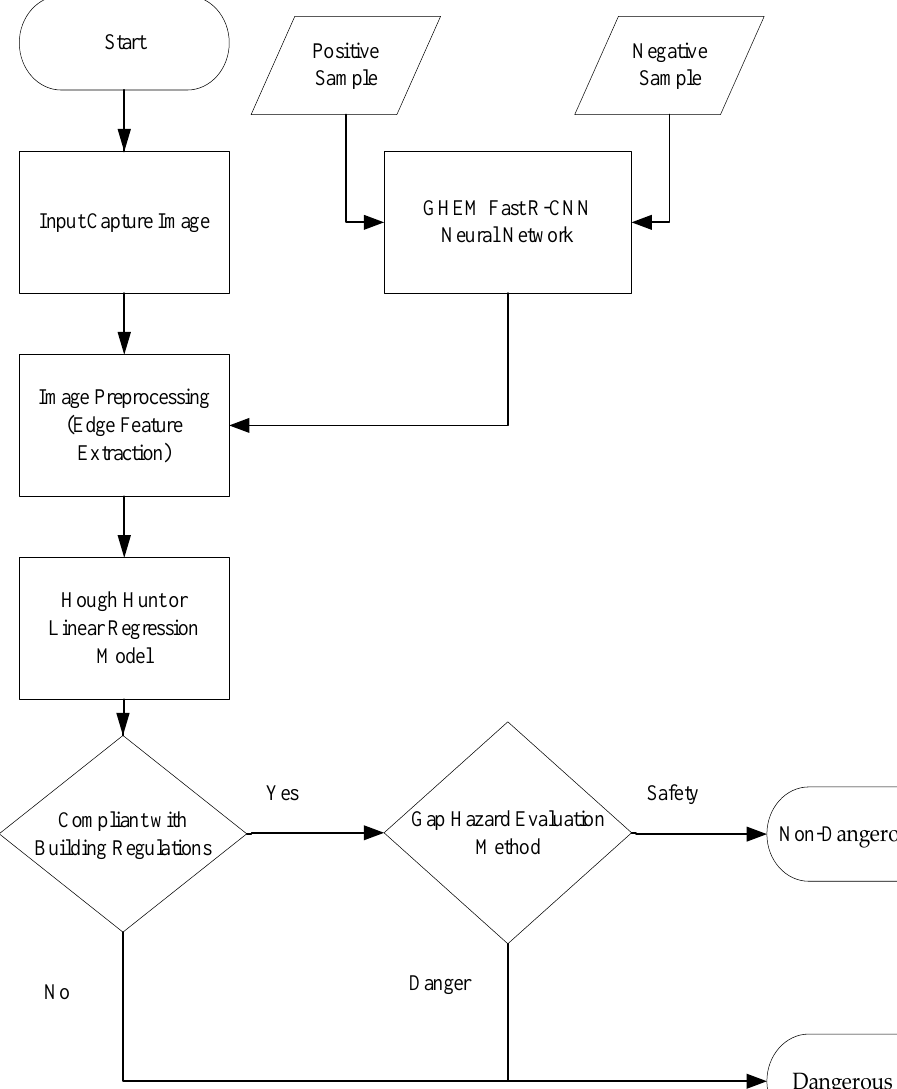
Figure 10. Gap hazard evaluation method and AI integration system process.